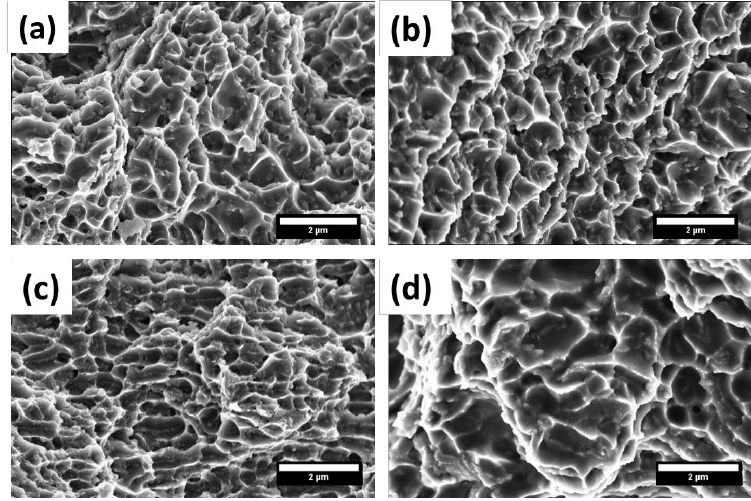
Figure 6. FESEM micrographs of the fracture surface of A357 samples built at ( a ) 100; ( b ) 140; ( c ) 170; and ( d ) 190 °C.